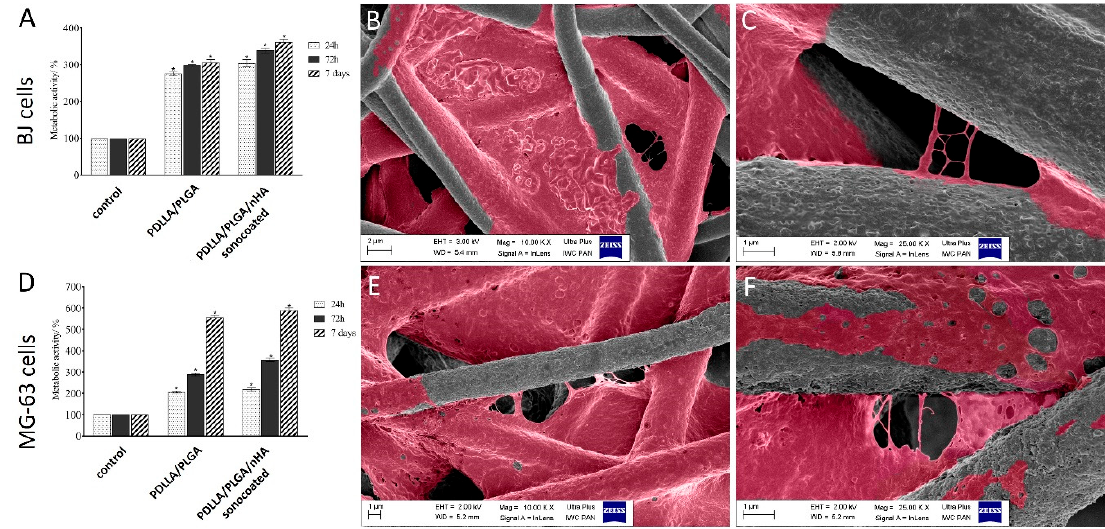
Figure 13. Metabolic activity of BJ ( A ) and MG-63 ( D ) cells seeded on PDLLA / PLGA and PDLLA / PLGA / nHA sonocoated materials after 24 h, 72 h, and 7 days. SEM colorized images of MG-63 cells attachment after 24 h on ( B , C ) PDLLA / PLGA and ( E , F ) PDLLA / PLGA / nHA sonocoated materials. ( B , E ): magnification 10kx; ( C , F ): magnification 25kx. Metabolic activity expressed as a percentage of the control, mean ± SD from three independent experiments. (*denotes statistically significant difference from unexposed control, p < 0.05).